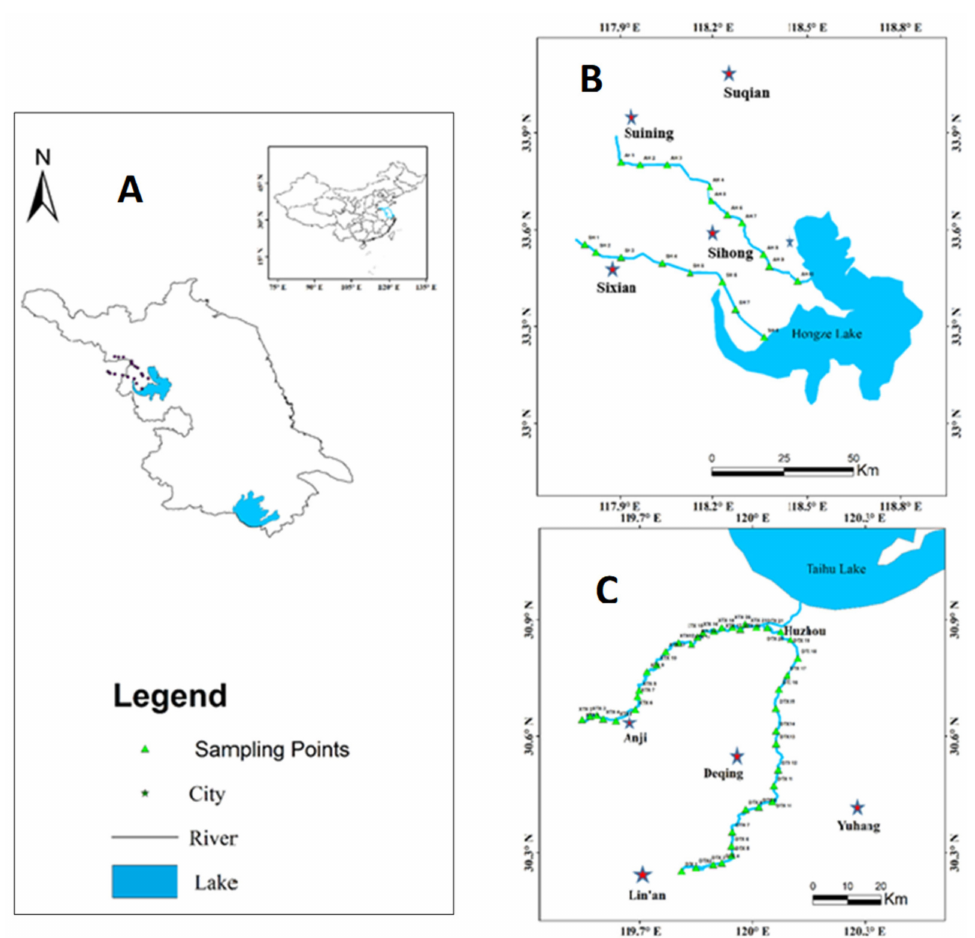
Figure 1. Map of the sampling sites showing ( A ) Northwest of Jiangsu province ( B ) Hongze watershed ( C ) Tiaoxi